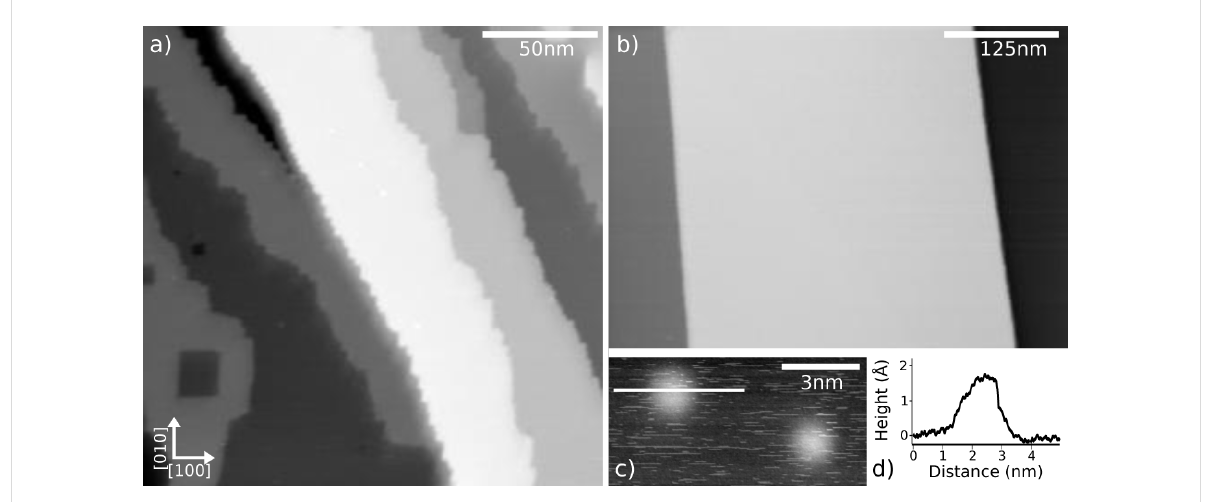
Figure 2: a) Topography image of the KBr(001) surface after the application of UHV-ESI with a mixture of toluene/isopropanol (2:1) over the course of 30 min. b) Topography image of clean KBr(001) surface obtained after UHV cleavage and following annealing at 400 K for 1h. c) Topography image of two protrusions with a profile (c) along the line. Parameters: a) A = 5 nm, Δ f = − 10 Hz, b) A = 2 nm, Δ f = − 60 Hz, c) A = 2 nm, Δ f = − 25 Hz.